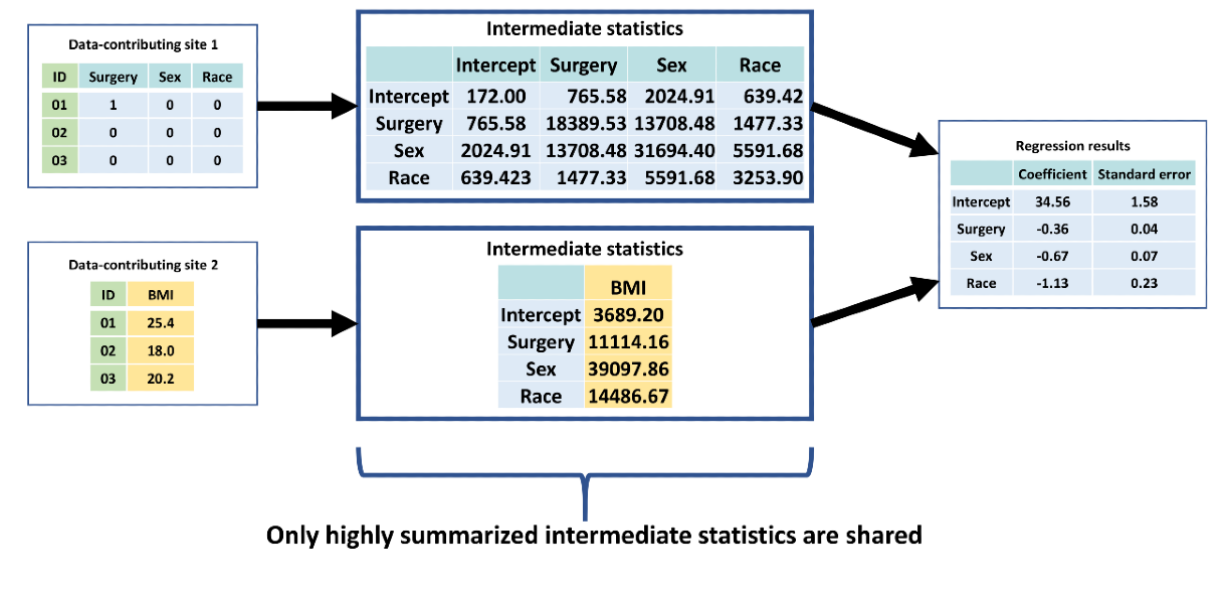
Figure 3. A hypothetical example of intermediate statistics shared by data-contributing sites in distributed linear regression analysis of vertically partitioned data. In this hypothetical example, surgery, sex, and race are the independent variables, while BMI is the dependent variable. Data-contributing site 1 has data on the independent variables, while data-contributing site 2 has data on the dependent